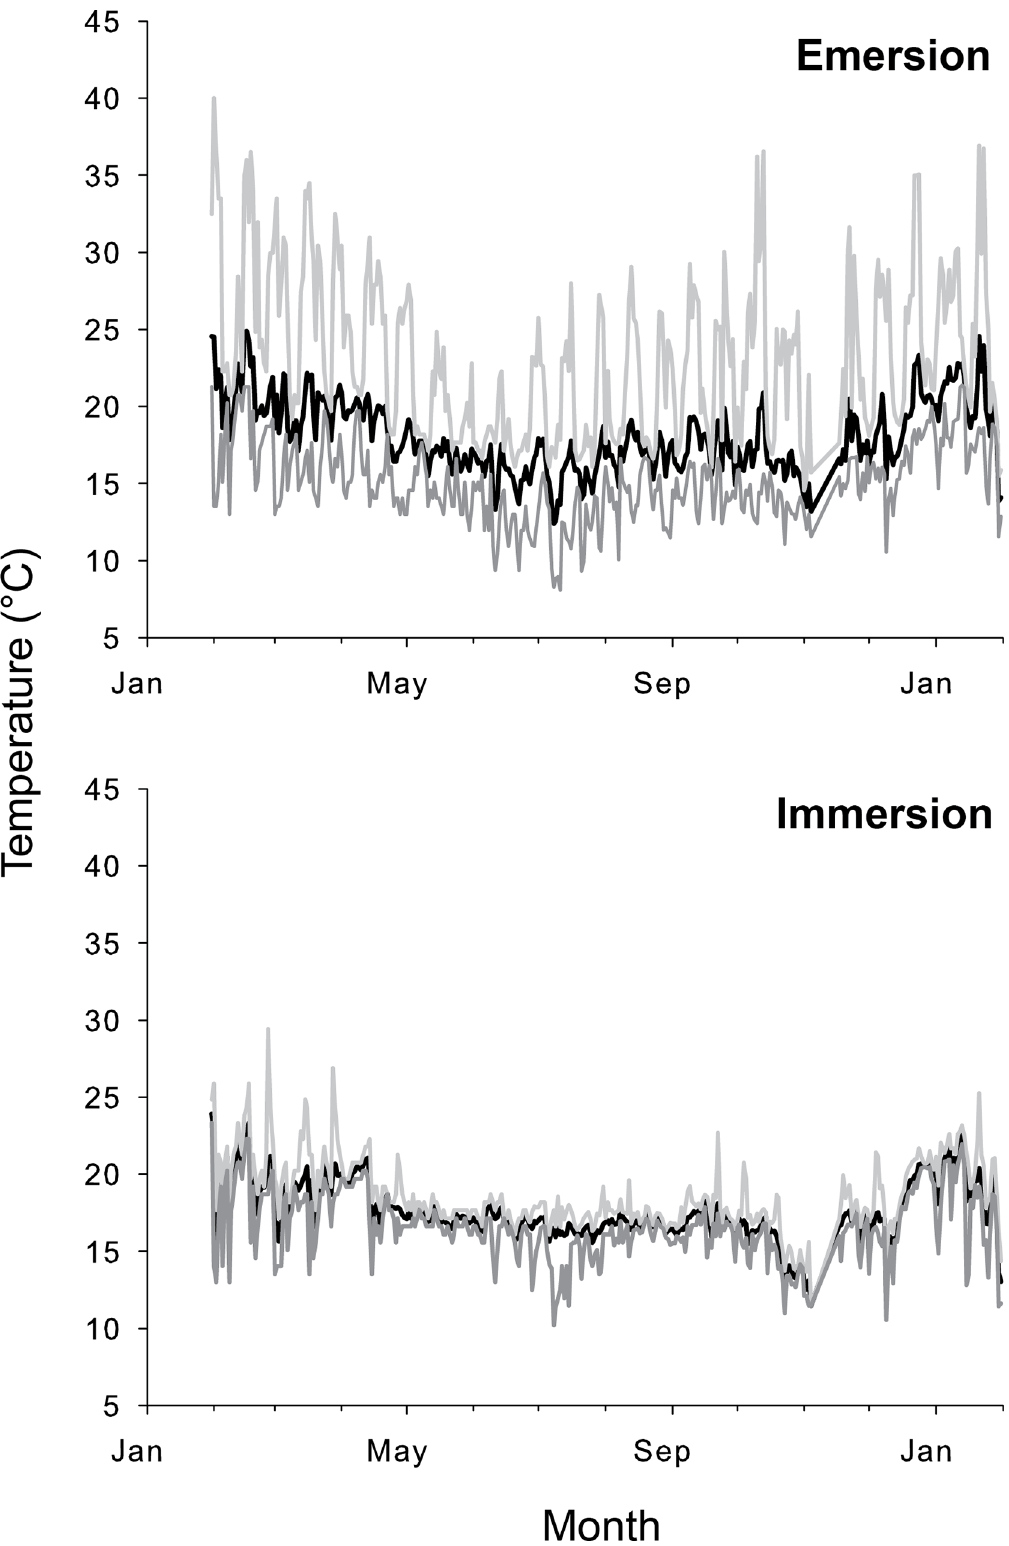
Fig 3. Daily mean (black line), maximum (light grey line) and minimum (dark grey line) temperatures recorded in-situ using robomussel data loggers at St. Francis Bay during both low and high tide.